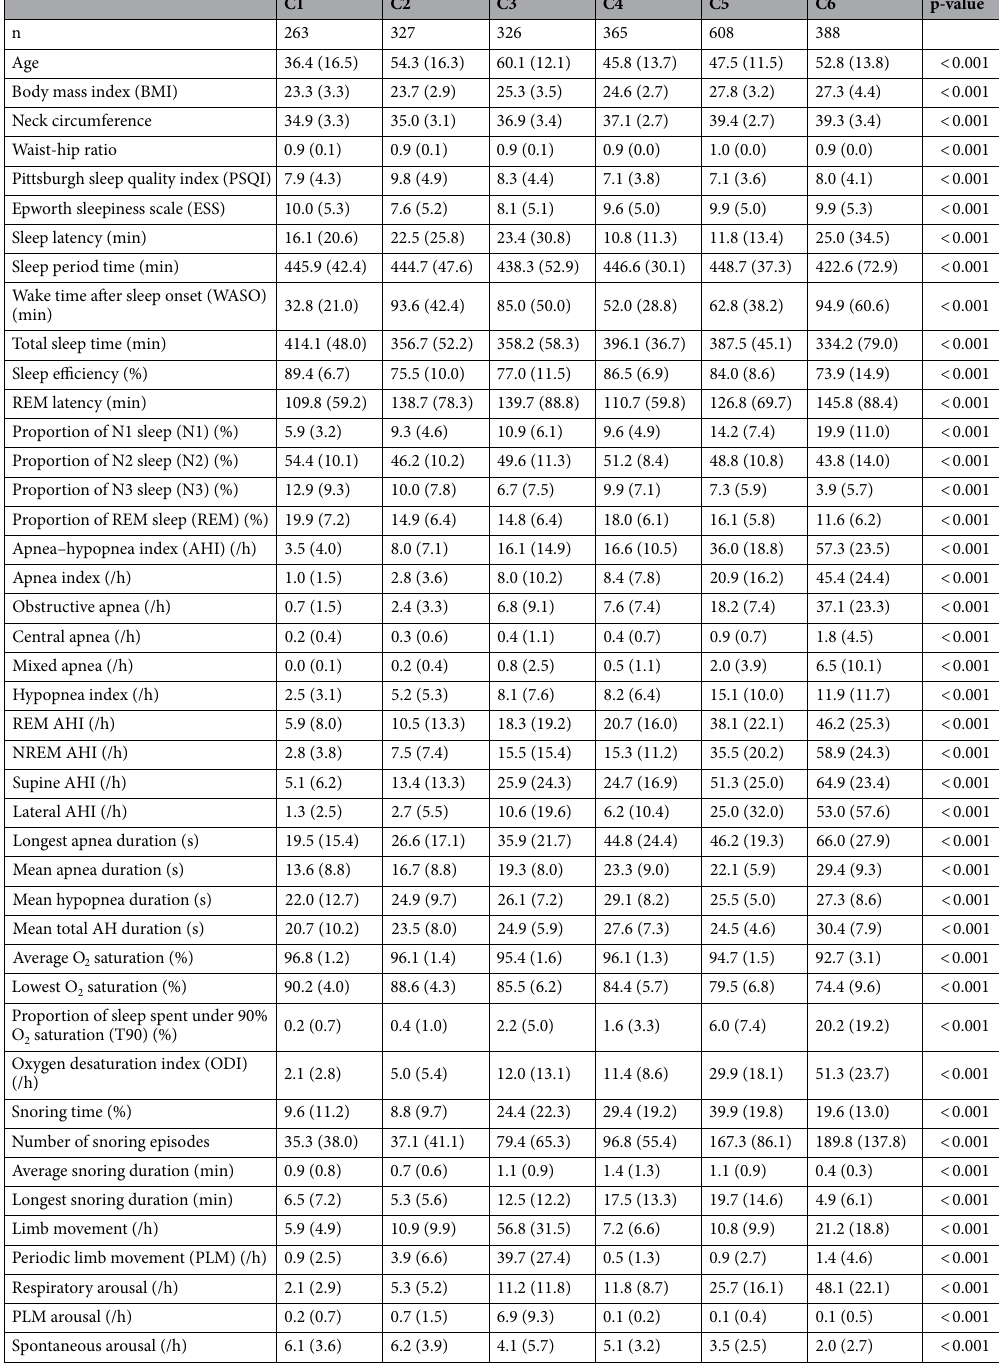
Table 1. Feature means (SD) of DPGMM-created clusters (n = 2277). Clusters were labeled in the order of increasing mean AHI. Omnibus analysis of variance was conducted for statistical